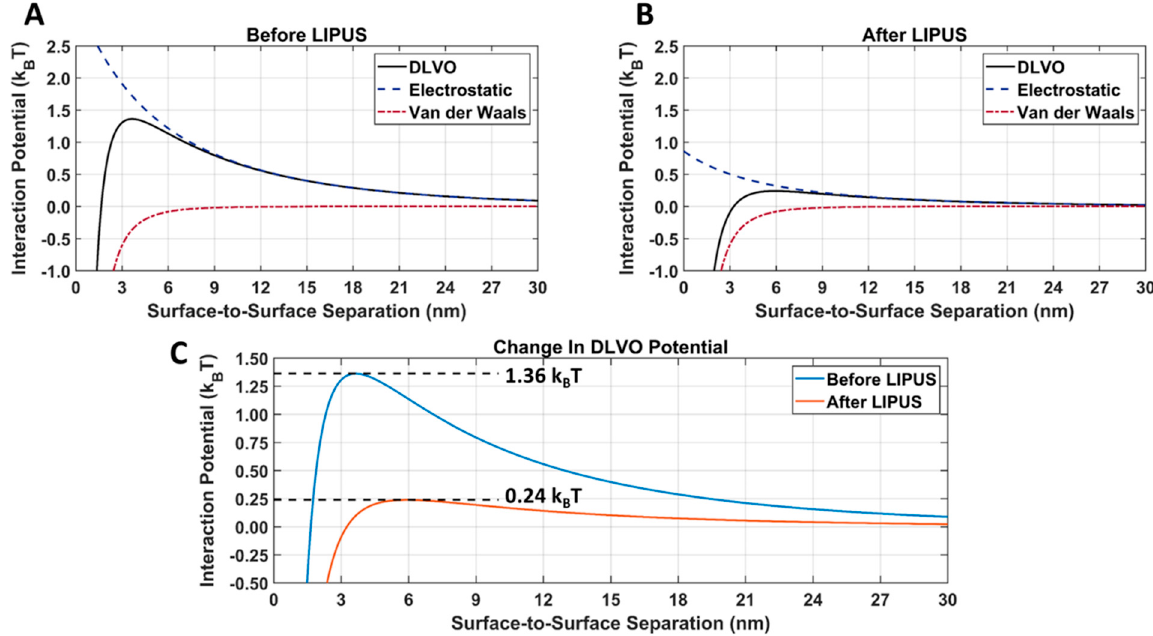
Figure 9. Attractive van der Waals and repulsive electrostatic DLVO total interaction potentials for DOX-loaded GNPs ( A ) before and ( B ) after LIPUS exposure; ( C ) a direct comparison of the DLVO total interaction potential before and after LIPUS